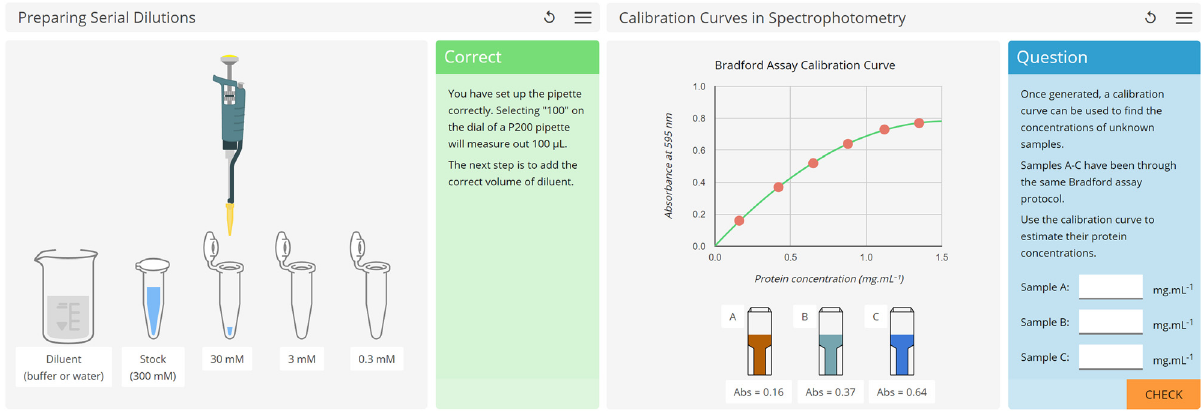
Figure 1: Two virtual activities related to the proper use of pipettes and a calibration curve. Taken from ref. [3], Creative Commons BY-ND